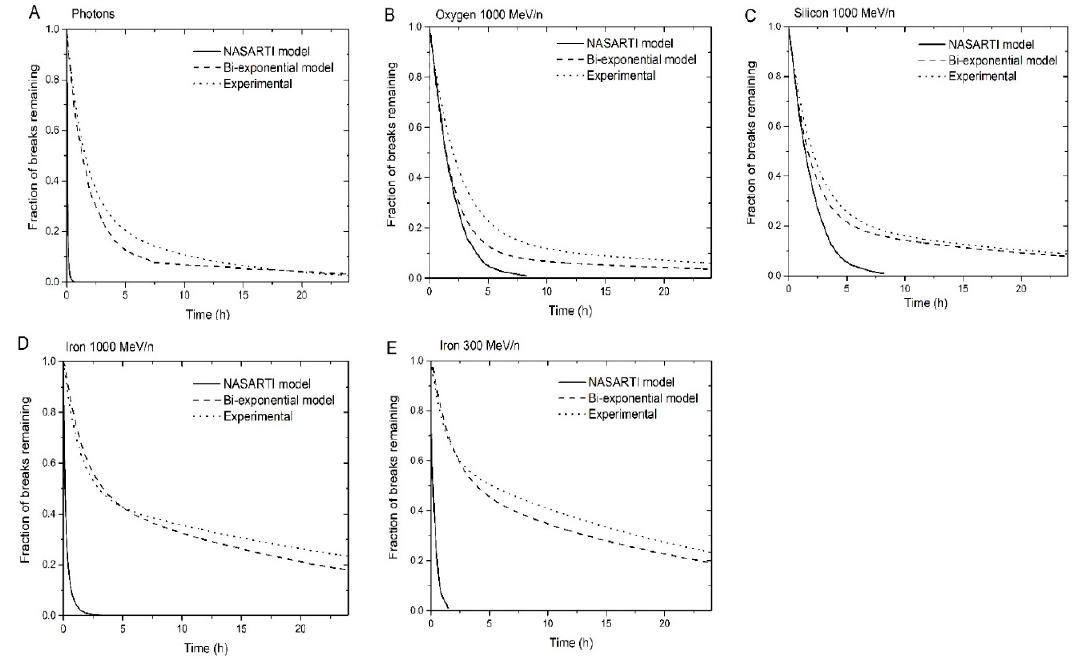
Figure 6. Repair kinetics obtained using the new restitution algorithm with a dose threshold set at 500 eV, and the results obtained from the former NASARTI algorithm and the experimental fit described in reference [9]: Photons ( A ), Oxygen 1000 MeV/n ( B ), Silicon 1000 MeV/n ( C ), Iron 1000 MeV/n ( D ), and Iron 300 MeV/n ( E ).